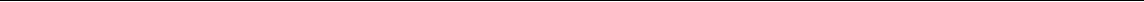
Fig. 6 Etanercept prevents ERG loss during murine liver injury. a C57/B6 mice were injected with mineral oil (vehicle; bi-weekly i.p) or with chronic CCl 4 administration (8 weeks, bi-weekly i.p); a third group was subjected to a 3-weeks recovery period following CCL 4 administration. Representative immuno fl uorescence of liver tissue samples stained for VWF (grey scale, green in merge), SMA (grey scale, red in merge) and ERG (white). Scale bar 50 μ m. Quanti fi cation of b SMA expression and c ERG expression (three fi elds per mouse, n = 3). Data were compared to mineral oil controls (*) or to chronic CCL 4 administration (#) by one-way ANOVA and Bonferroni multiple comparison post-test. d Representative immuno fl uorescence following acute (48 h) mineral oil, CCL 4 or co-administration of etanercept and CCl 4 . Staining for ERG (white); merged images showing VWF (green), SMA (red) and DAPI (blue). e pSMAD3 (white; stars); other colours as in d ; scale bar 20 μ m. f – h : Quanti fi cation of f SMA, g ERG and h pSMAD3 expression (three fi elds per mouse, n = 3). Data were compared to mineral oil controls (*) or to 48 h CCL 4 administration (#) by one-way ANOVA and Bonferroni multiple comparison post-test. i Co-administration of etanercept and CCL 4 for 48 h was able to signi fi cantly reduce SMA expression in Erg fl / fl mice while it was ineffective in Erg cEC-Het mice. Representative immuno fl uorescence of liver tissue, colour scheme as above. Scale bar 50 μ m. j Quanti fi cation of SMAD2/3 target gene expression by qPCR in liver tissue of Erg fl / fl mice injected with etanercept and CCL 4 compared to CCL 4 alone (*) or Erg cEC-Het treated with etanercept and CCL 4 compared to CCL 4 alone (#). k Quanti fi cation of SMA expression (three fi elds per mouse, n = 3). Data analysed by one-way ANOVA and Bonferroni multiple comparison post-test. All graphical data are mean ± s.e.m., * or # P < 0.05, ** or ## P < 0.01, *** or ### P <